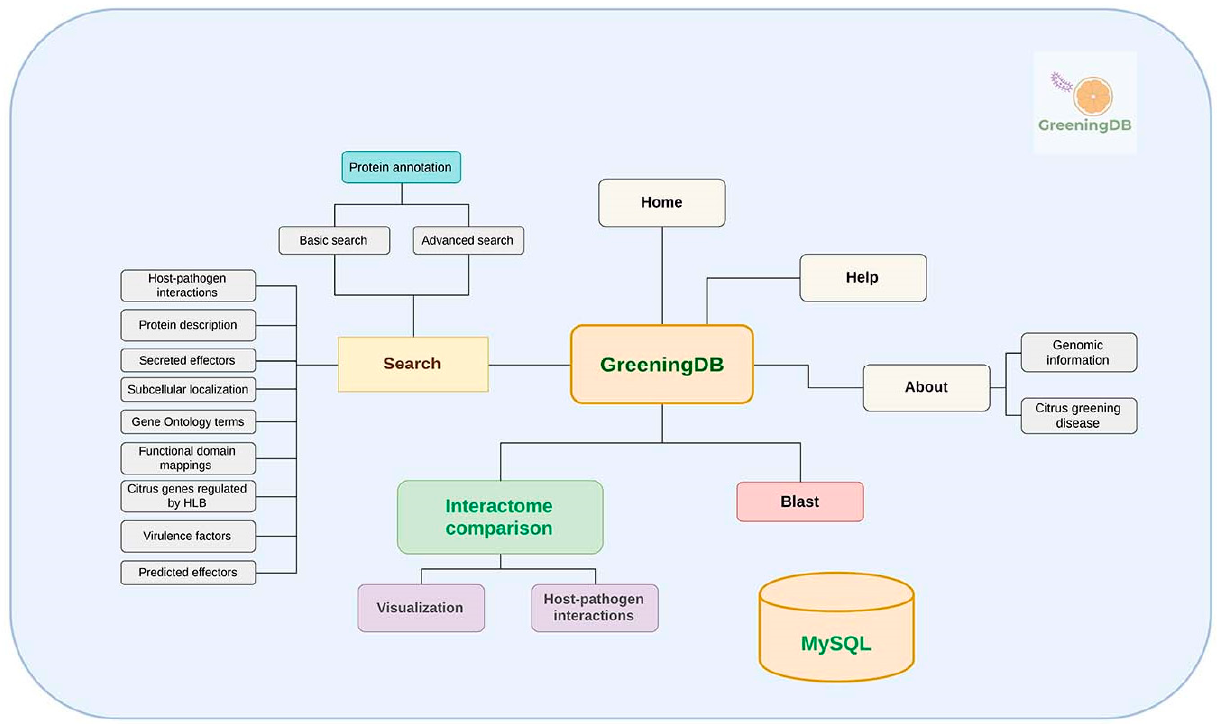
Figure 3. An overall view of the GreeningDB database